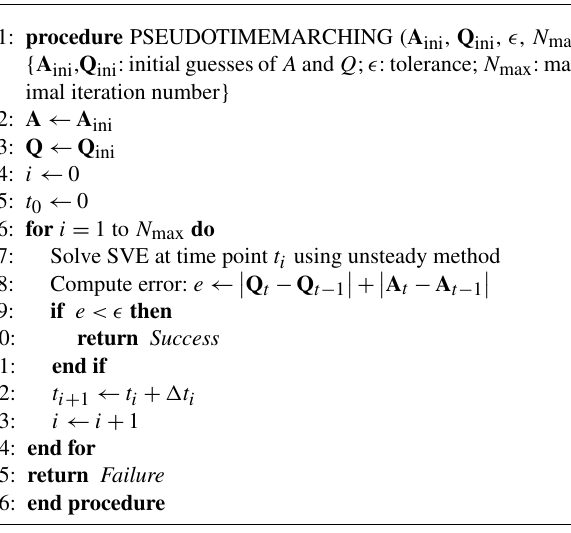
Algorithm 1 Pseudo time-marching method